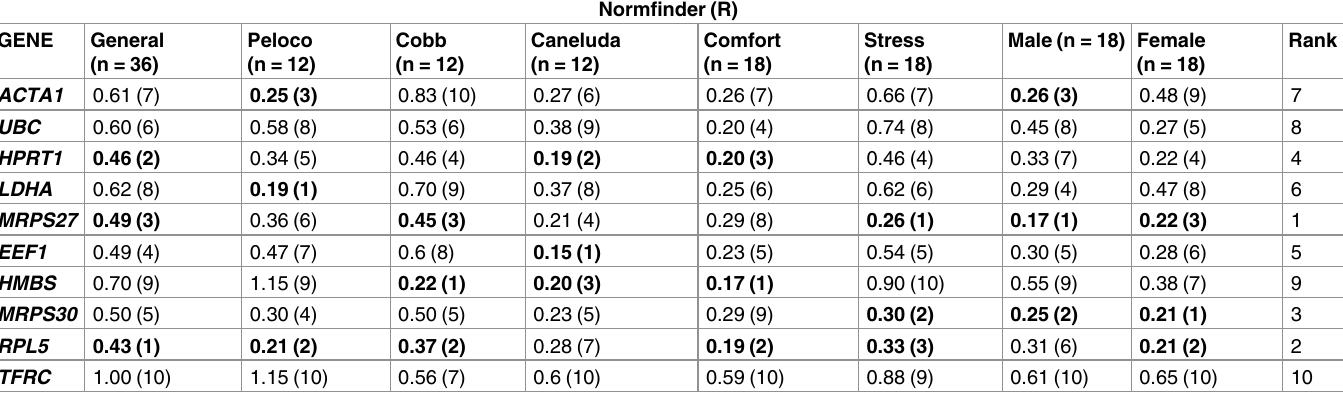
Table 6. Ranking with stability values for each treatment (genetic group, sex, and environment) in chicken obtained from NormFinder. Values into the parenthesis refer to ranking by Normfinderto each treatment. Valueson the last column refer to the rankingposition by RankAggreg packageamongall the treatments.